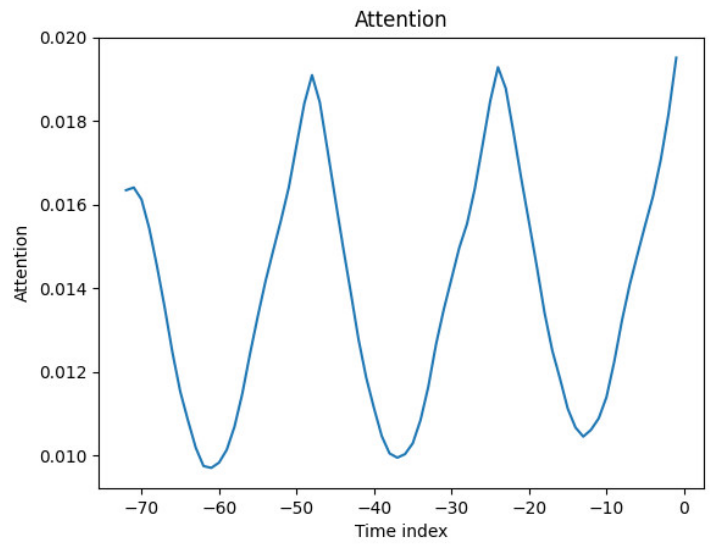
Figure 13. Importance of decoder variables.